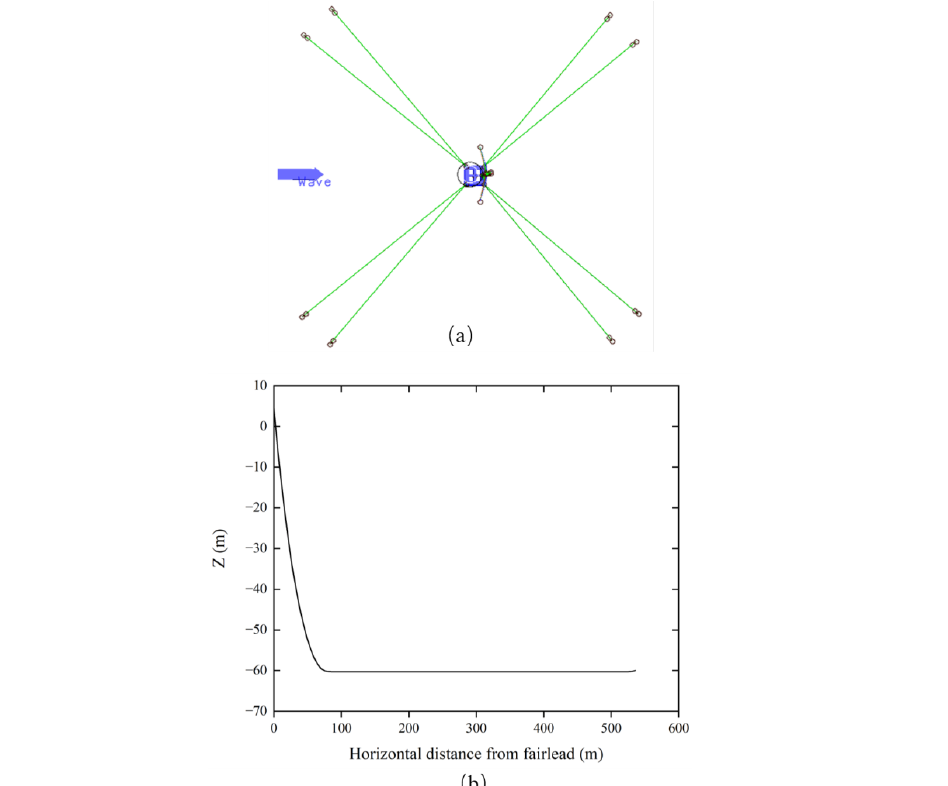
( b ) Configuration of a mooring line in the projected Configuration of a mooring line in the projected view.